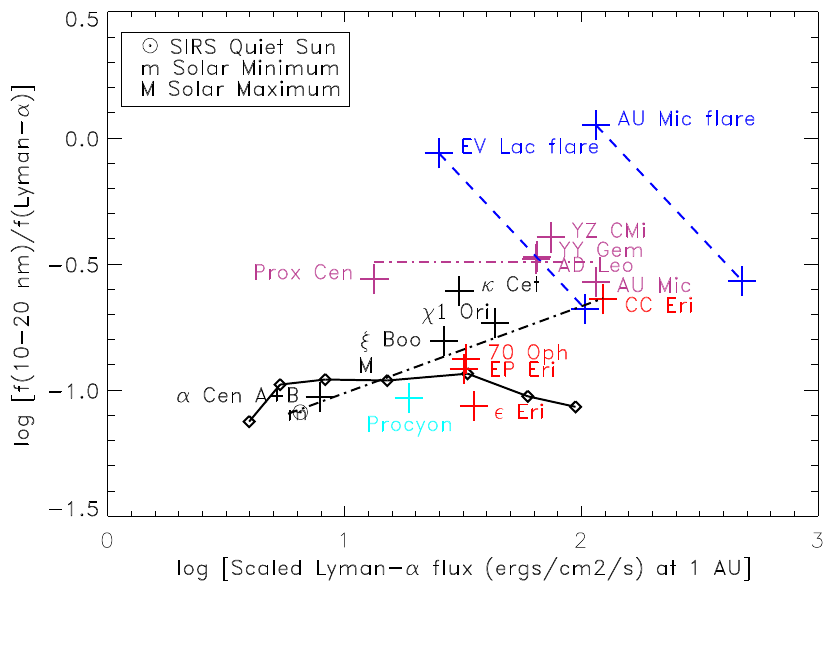
Figure 11. Ratios of the 10–20 nm intrinsic stellar flux (corrected for interstellar absorption) divided by the reconstructed Ly α flux vs . the reconstructed Ly α flux at 1 AU scaled by the ratio of stellar radii squared. The solid line-connected diamonds are the flux ratios in this passband for the Fontenla et al . [30] semiempirical models 13 × 0 to 13 × 8 (from left to right). Flux ratios for one F star (cyan), four G stars (black), four K stars (red), and five M stars (plum) based on EUVE spectra are shown as ± 15 error bar symbols. The dash-dot (black) line is the least-squares fit to the solar and F, G, and K star ratios. The plum dash-dot line is the mean of the M star ratios excluding the flare data for the stars EV Lac and AU Mic. Flux ratios for EV Lac and AU Mic during flares (blue) are plotted two ways. The upper left symbols are ratios of EUV flare fluxes to quiescent Ly α fluxes. Dashed lines extending to the lower right indicate the ratios for increasing Ly α flux. The symbols at the lower end of the dashed lines are ratios obtained using the most likely values of the Ly α fluxes during flares. The “m” and “M” symbols are the solar minimum and maximum ratios obtained with the SEE instrument. The Sun symbol is the ratio for the SIRS quiet Sun data set. Figure from Linsky et al . with copyright permission